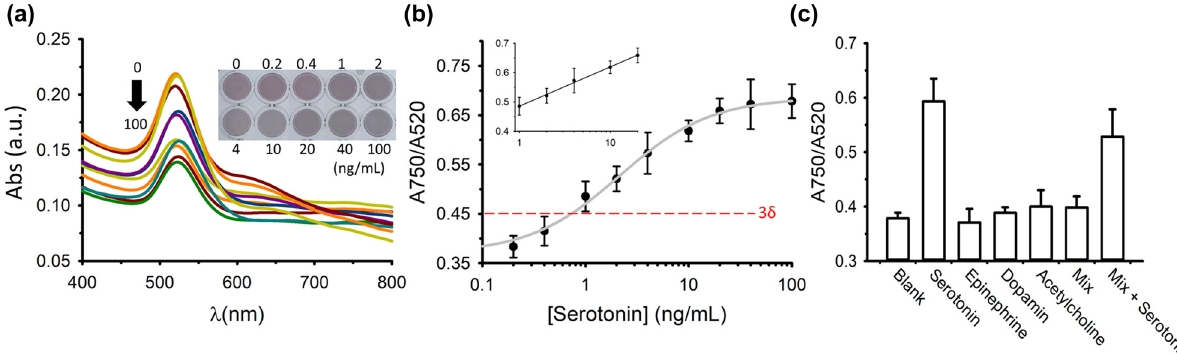
Figure 4: Sensing performance of the colorimetric AuNPs for serotonin. ( a ) Absorption spectra of the AuNP solution at various serotonin concentrations. The inset shows the image of the AuNP solution containing di ff erent concentrations of serotonin. ( b ) Calibration plot of serotonin using the ratio of the absorbance at 750 and 520 nm of the AuNP solution at various serotonin concentrations. “ 3 σ ” is drawn at the zero - dose value plus thrice the standard deviation of the zero - dose measurements. The linear relationship was observed at the serotonin concentration from 1 to 20 ng/mL ( R 2 = 0.997 in the inset ) . The fi nal concentrations of aptamer, Au 3 + , ascorbic acid, and NaCl were 20 nM, 333 µM, 2.5 mM, and 28 mM, respectively, and their pH was 4. ( c ) Absorbance ratio in the presence of related interfering molecules at 20 ng/mL. The concentration of serotonin used in the speci fi city was 10 ng/mL. Mix represents the reaction solution containing all the interference molecules except for serotonin at 20 ng/mL. The error bars represent the standard deviation of the mean of three measure - ments ( for the representation of the curves in this fi gure in color, the reader is referred to view the web version of this article )